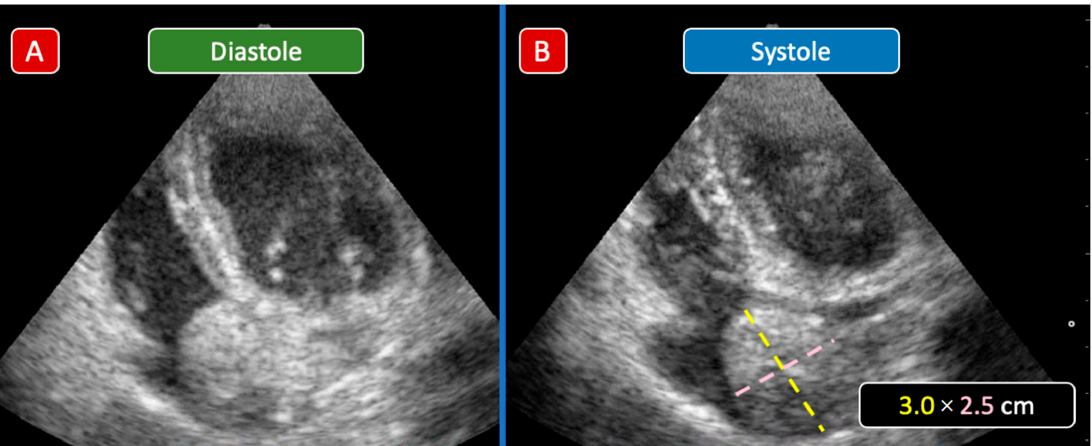
Figure 3. Case 2 echocardiographic images. Apical 4 chambers view: a 3.0 × 2.5 cm rounded mass is clearly seen inside the RA. Compared to the other case, the mass has limited motion with